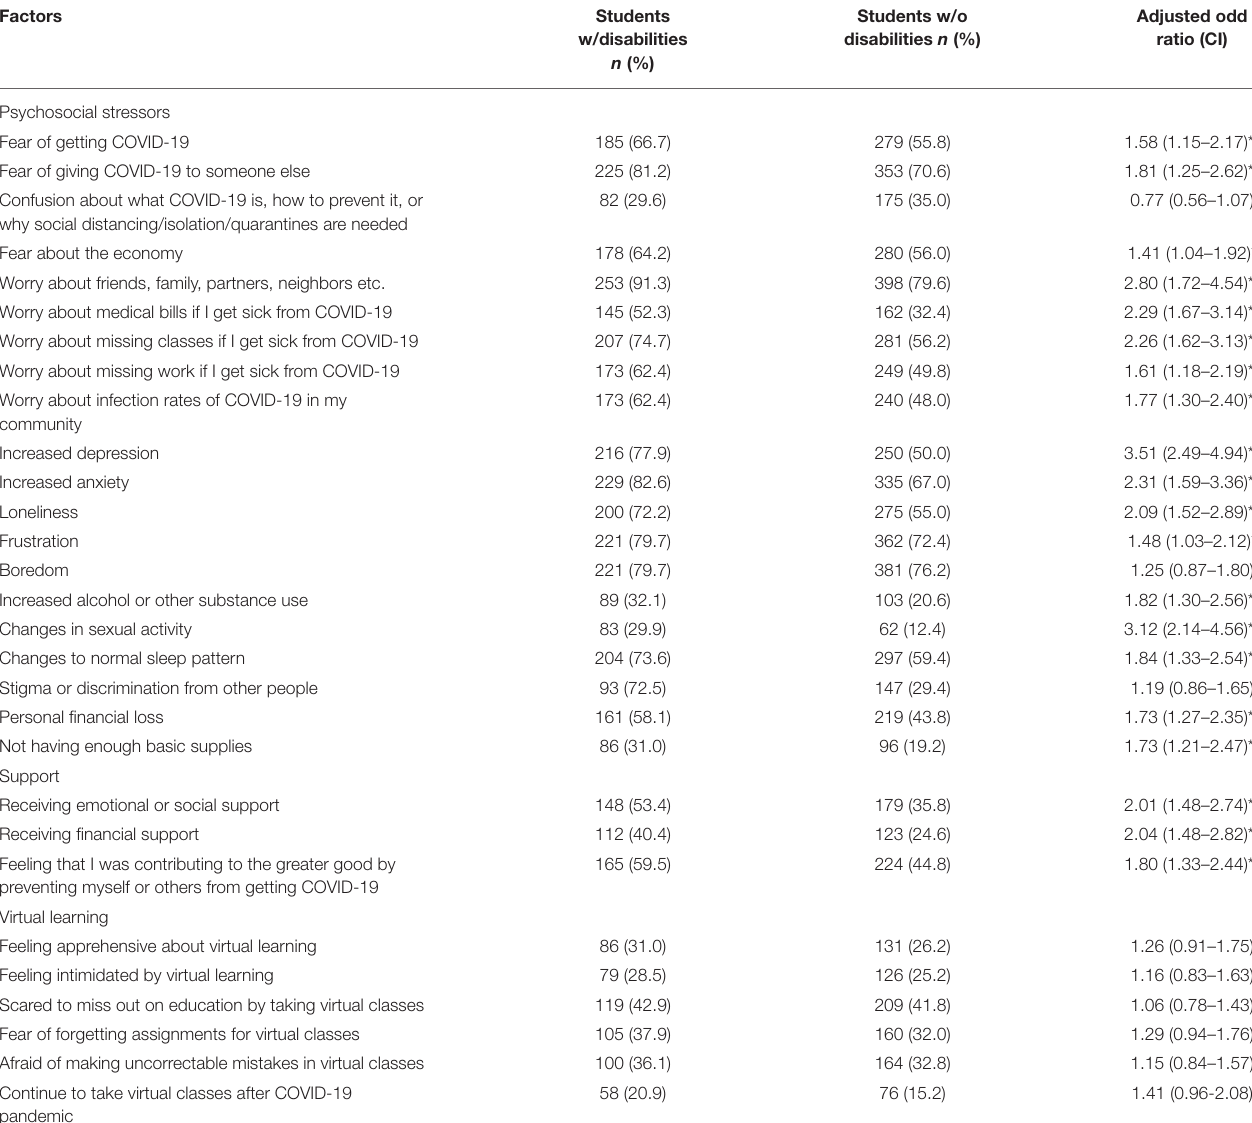
TABLE 4 | Adjusted likelihood of experiences during COVID-19 pandemic between students with (w/) disabilities ( n = 277) and students without (w/o) disabilities ( n =